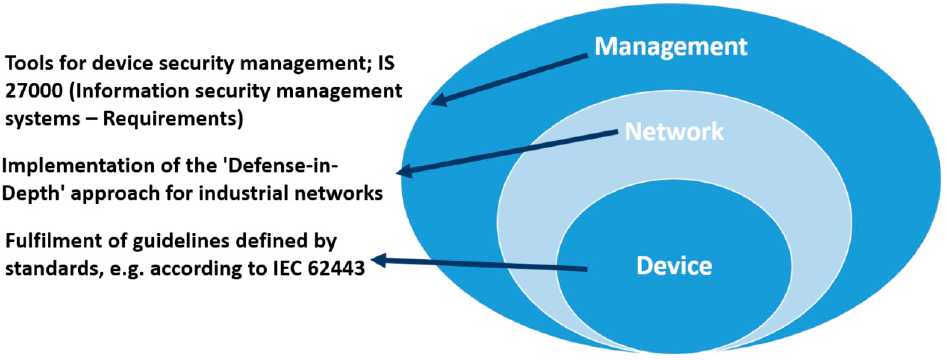
Figure 28. Key levels of cyber security and users’ requirements and needs. Source: own contribution based on [313].